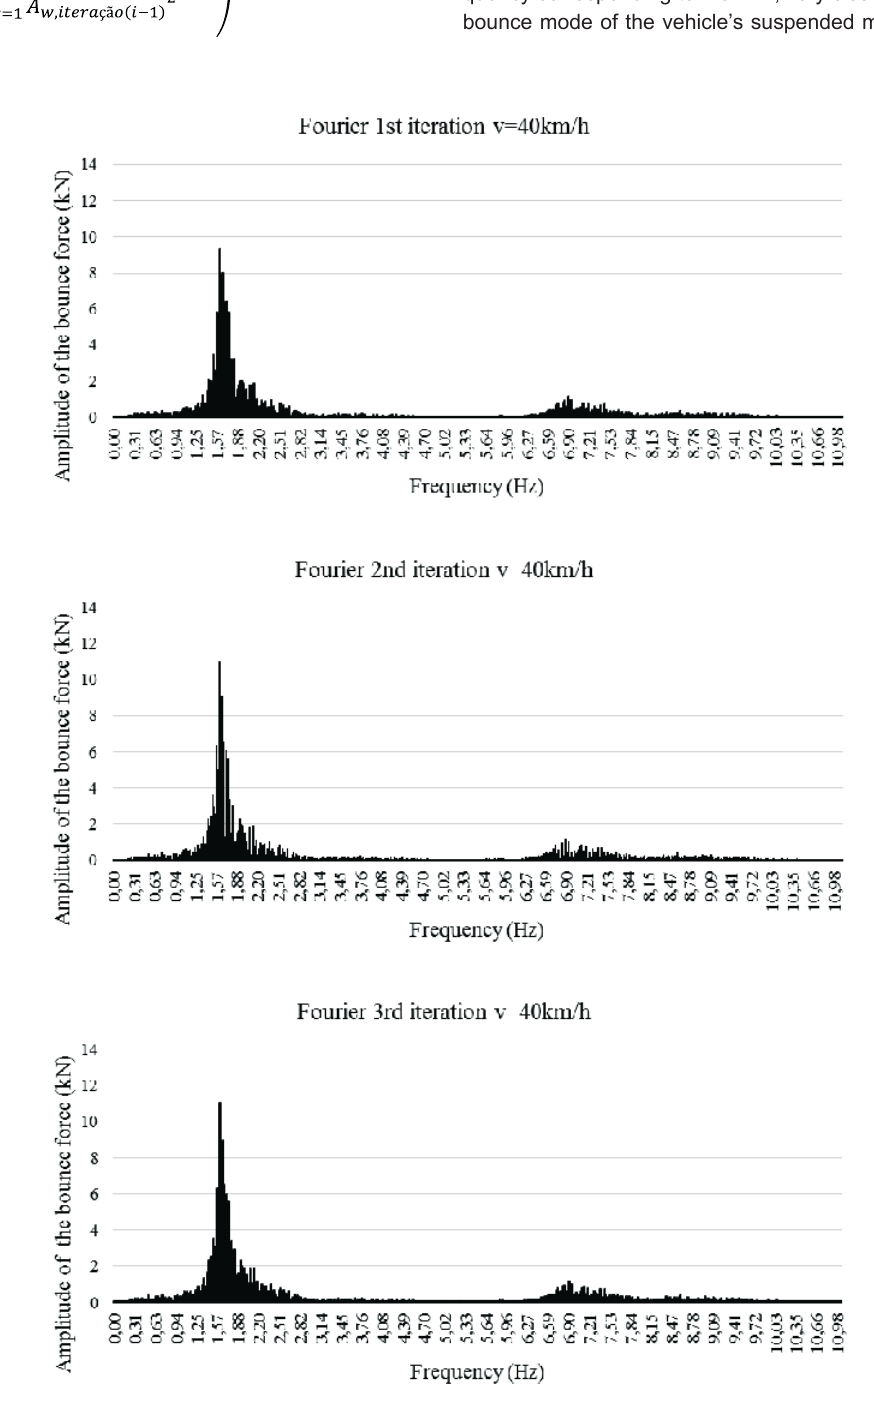
Fourier analysis of bounce forces F